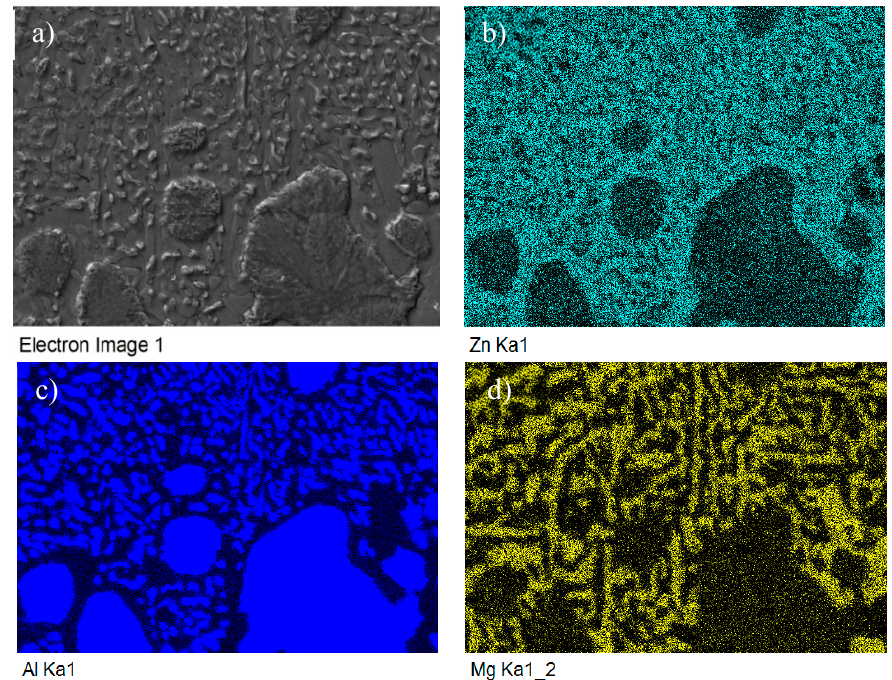
Figure 12. The map of Mg, Zn and Al elements in the structure of Zn5Al3Mg solder.